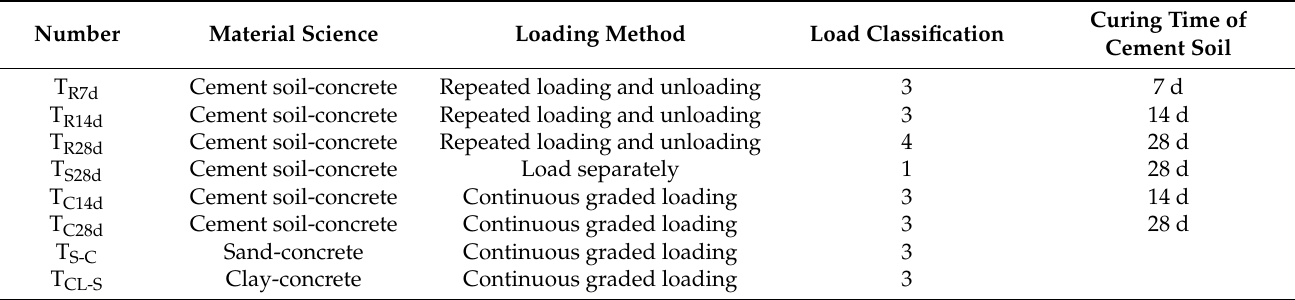
Table 1. Classification of the test